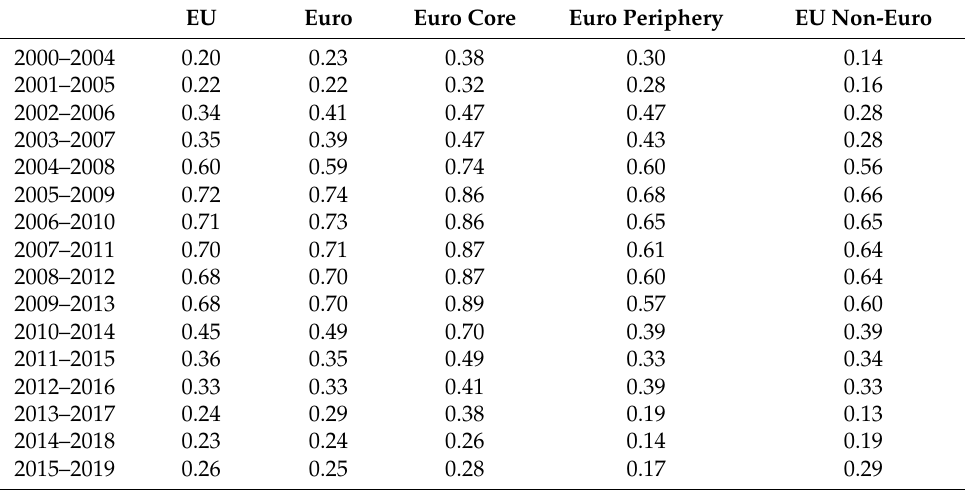
Table 1. Real GDP growth rates—averages of country-level correlation coefficients for different country groups.